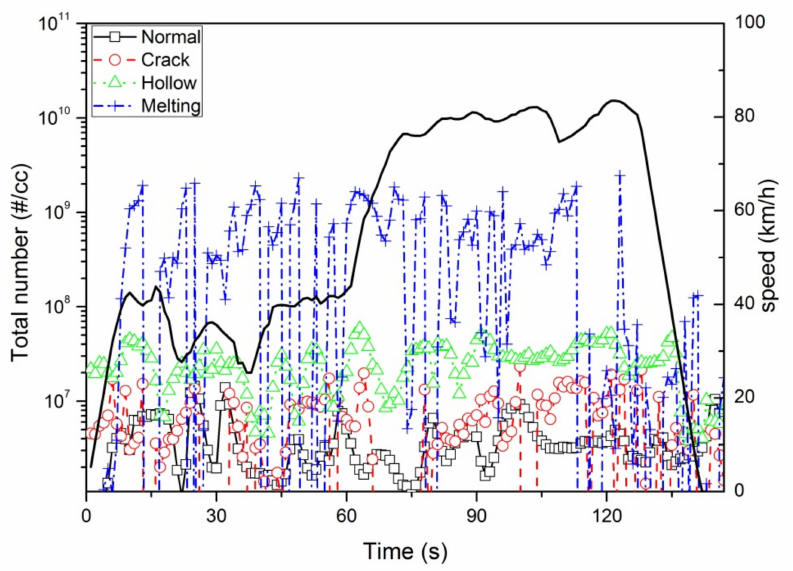
Figure 13. Total PN density during KD-147 driving mode (black line) for 4 types of DPF